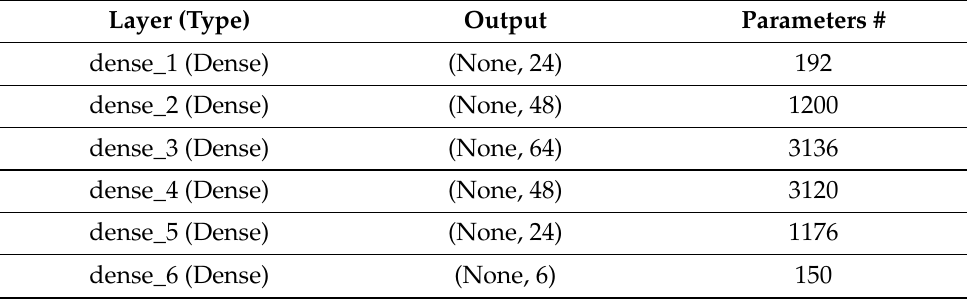
Table 3. Structure of the ANN for model number 1 of deep reinforcement learning